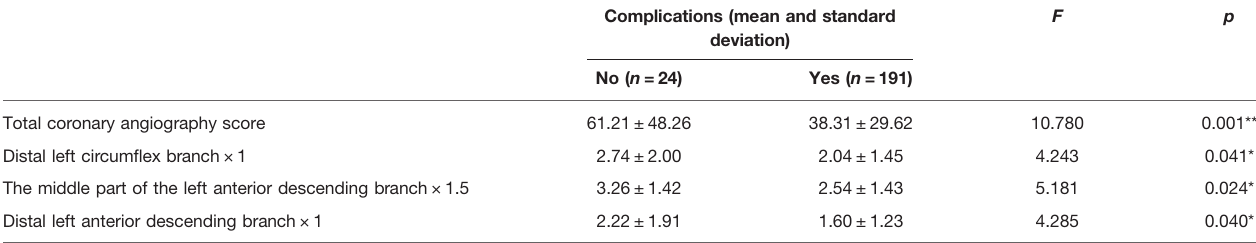
TABLE 6 | Variance analysis for the presence of complications and distal left circum fl ex branch×1, the middle part of the left anterior descending branch×1.5, and the distal left anterior descending branch×1.